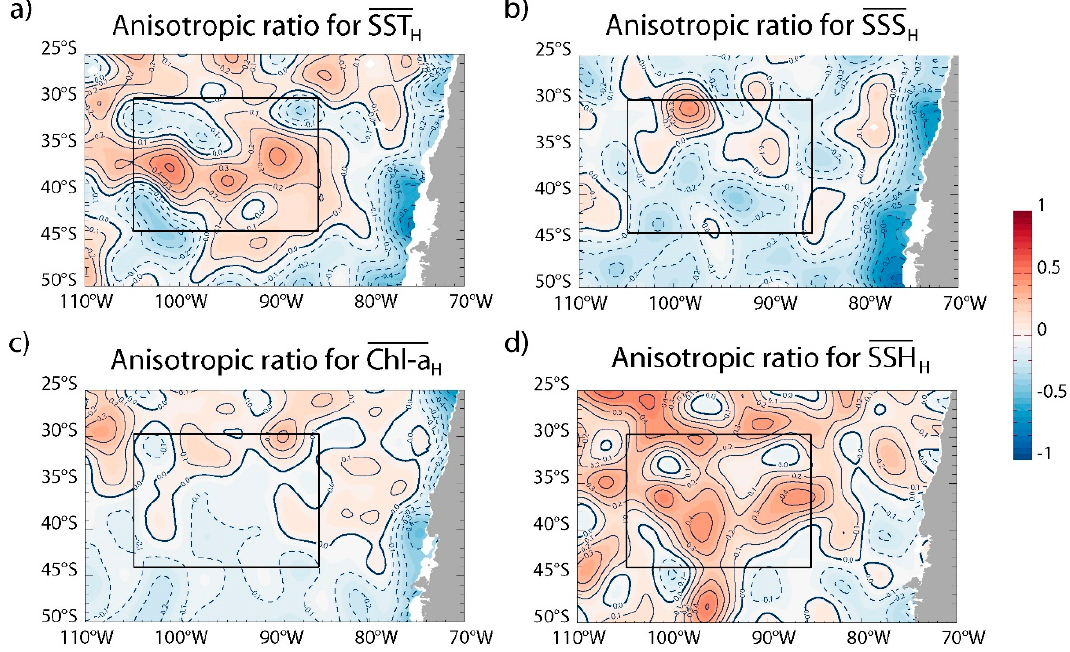
Figure A2. Same as Figure A1, except for the ESP. The solid box on all the panels corresponds to the dashed box on